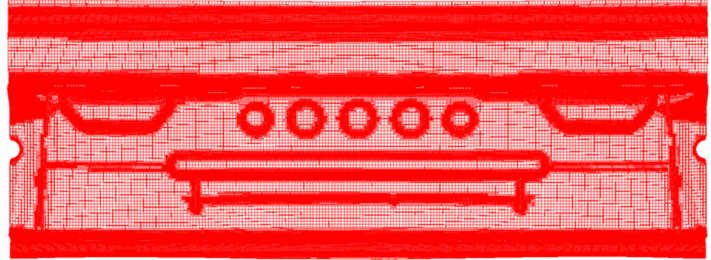
Figure 14. Finite element model of the final part.